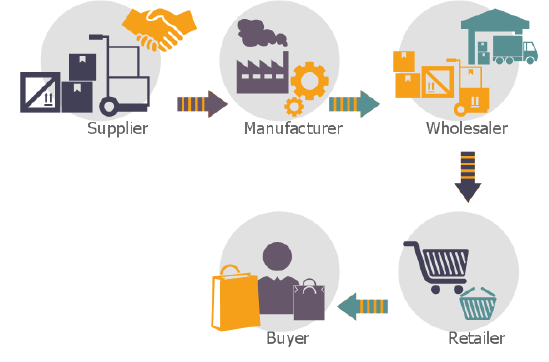
Figure 2: Activities in Logistics